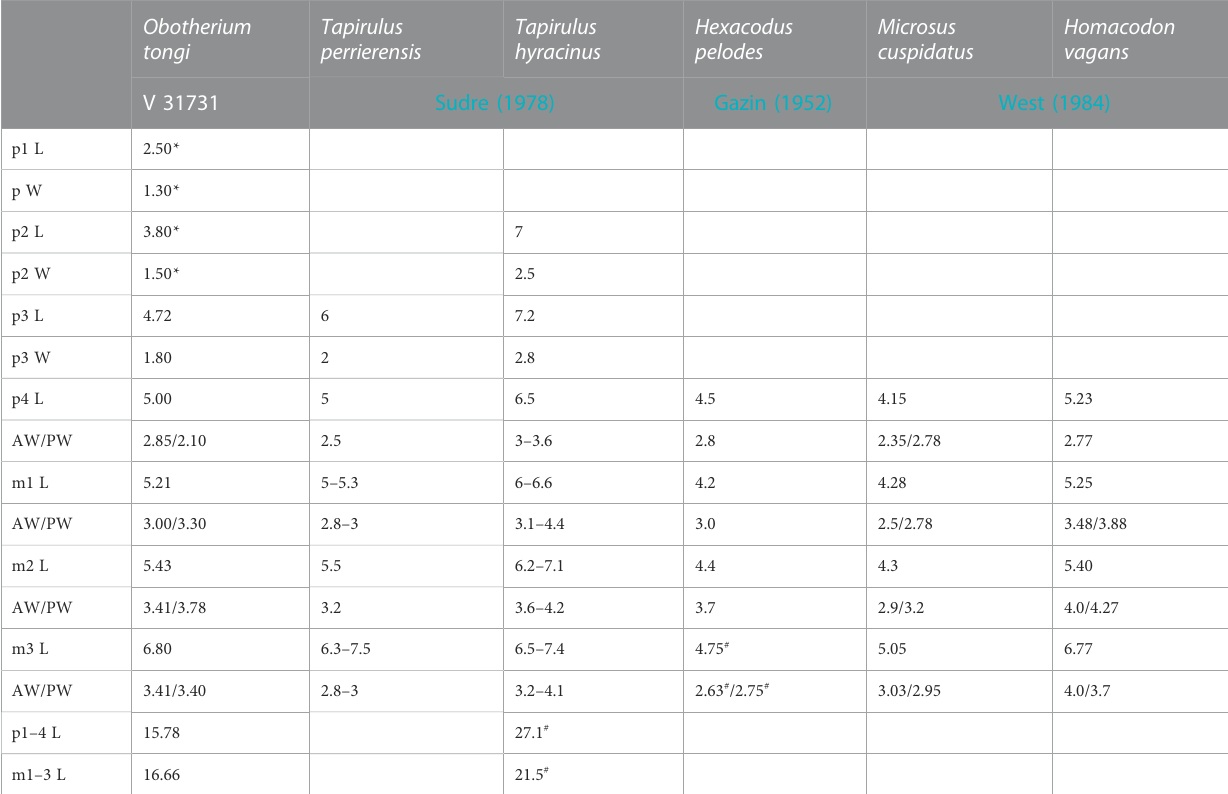
TABLE 2 Comparative measurements of Obotherium tongi and other related taxa. (in mm) (*: approximate value; #: measured from the plate). Obotherium